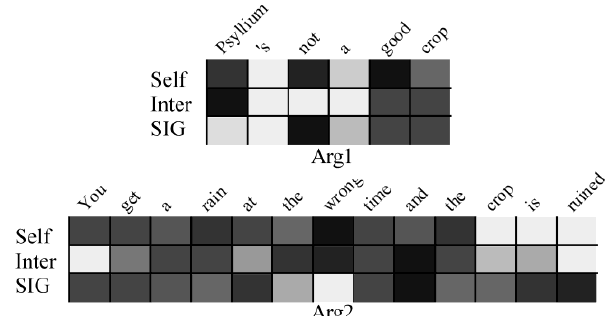
Figure 5. Example 3 gray scale of attention distribution obtained from different systems